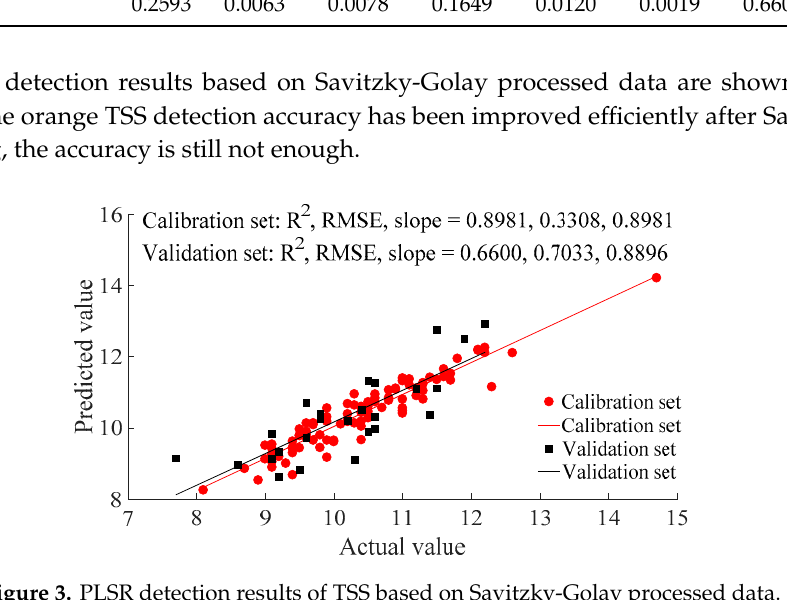
Figure 3. PLSR detection results of TSS based on Savitzky-Golay processed data.